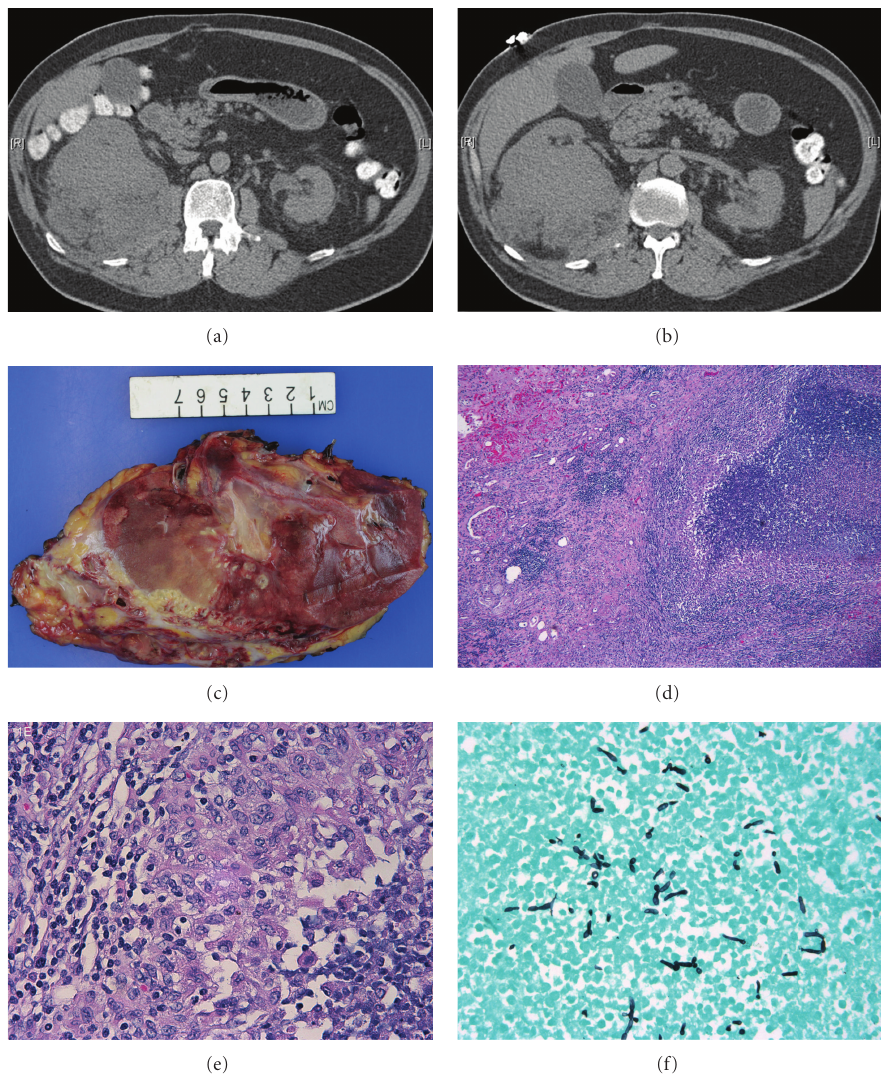
Figure 1: (a) Unenhanced CT of the abdomen displays a large, contour deforming mass arising in the lower pole of the right kidney. The mass contained no visible calcifications, involved the renal capsule, and infiltrated the perinephric fat. (b) More inferiorly, the mass clearly involved the ipsilateral psoas muscle and, after going through the perinephric space and fascia, it extended into the posterior paranephric space. There is no retroperitoneal lymphadenopathy. The right renal vein was of normal caliber on higher slices through the renal hilum. (c) Gross examination. The mass involved renal parenchyma with extrarenal extension. (d) Granulomatous inflammation with abscess involved renal parenchyma, H&E, × 50. (e) Granuloma with adjacent abscess was seen in the renal parenchyma, H&E, × 400. (f) Grocott stain was positive for pseudohyphae and yeast forms, ×